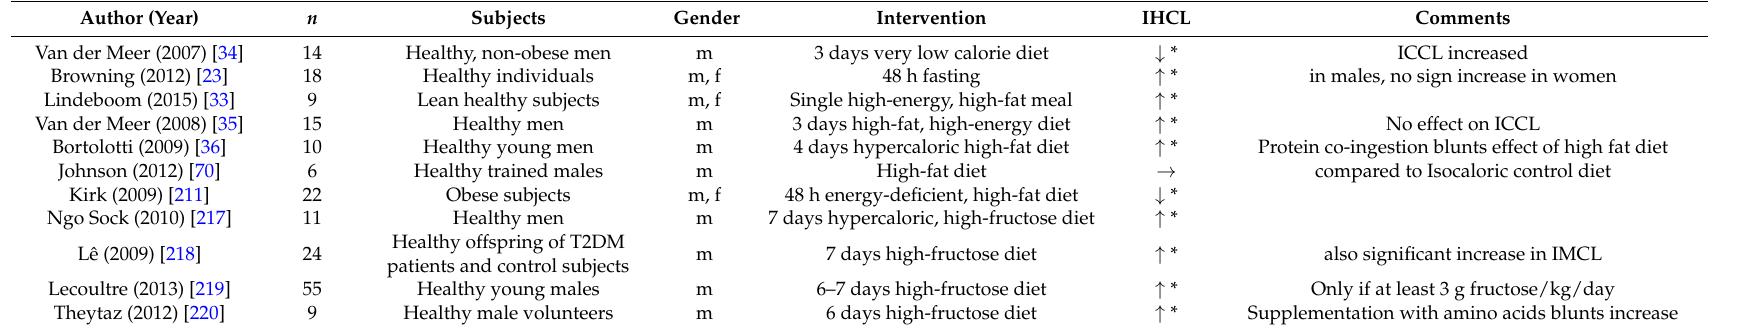
Table 4. Effect of short-term dietary interventions on IHCL using 1